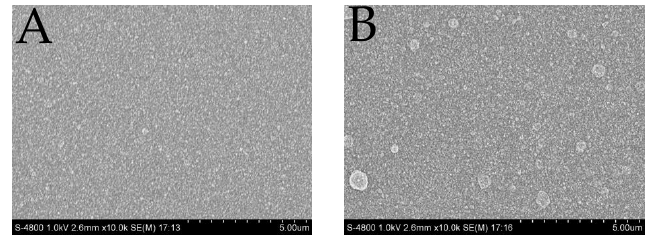
Figure 5. The scanning electron microscope (SEM) of 6 ( A ) and 10 ( B ) cycles PEDOT films with the magnification of 10 K and minimum scale of 500 nm.